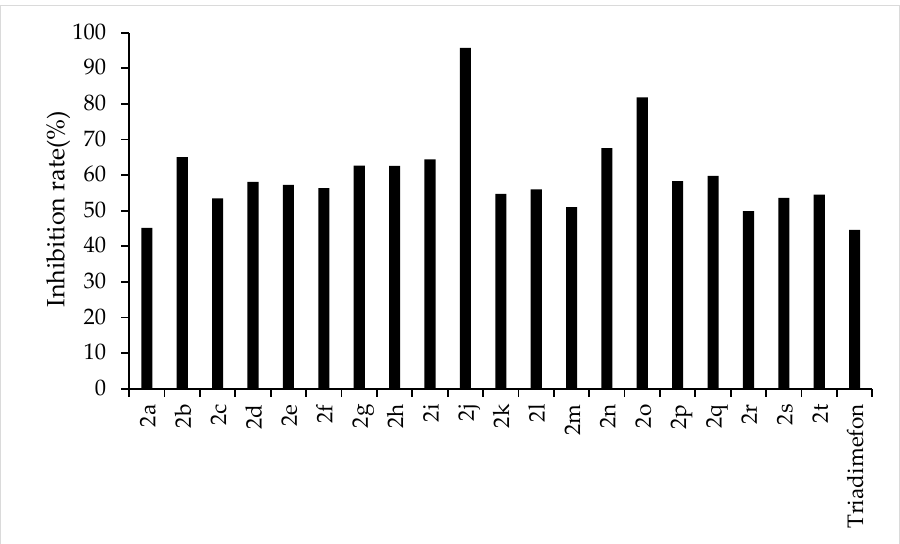
Figure 4. Antifungal activity of the target compounds ( 2a ‒ 2t ) against F. oxysporum.